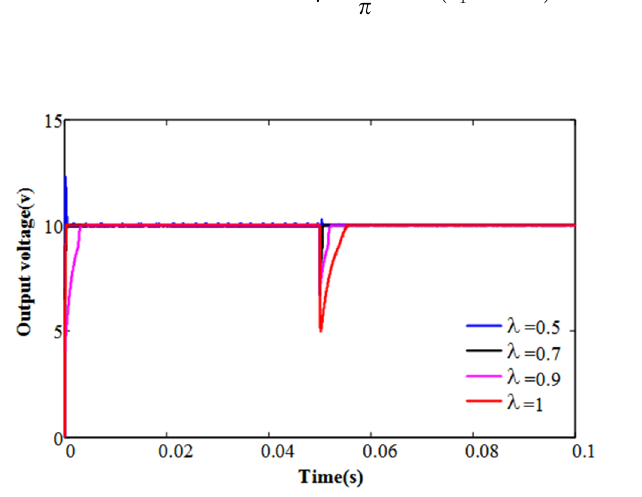
Fig 4. The output voltage dynamic response with different λ